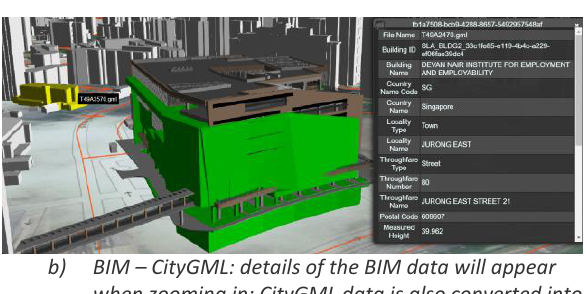
Figure 2: BIM- Shapefile-CityGML and QUEST output data integration in the Multi-dimensional platform